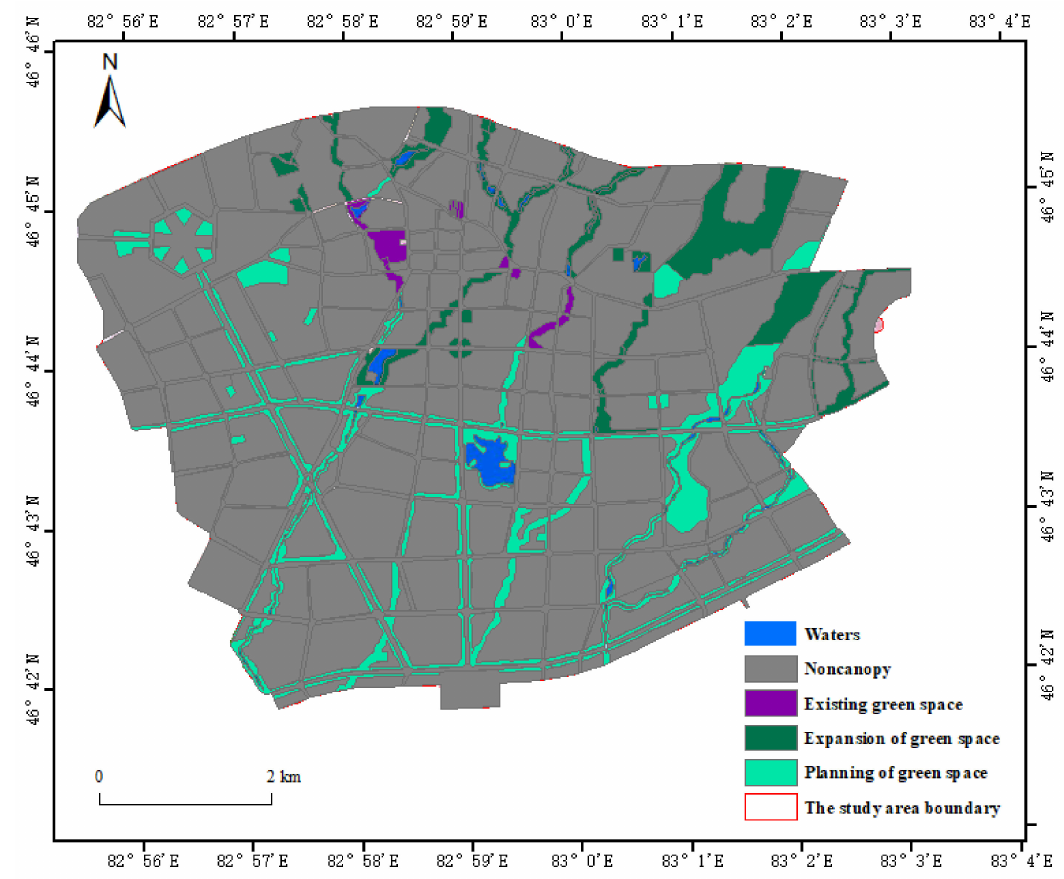
Figure 2. Basic data map of green space in the study